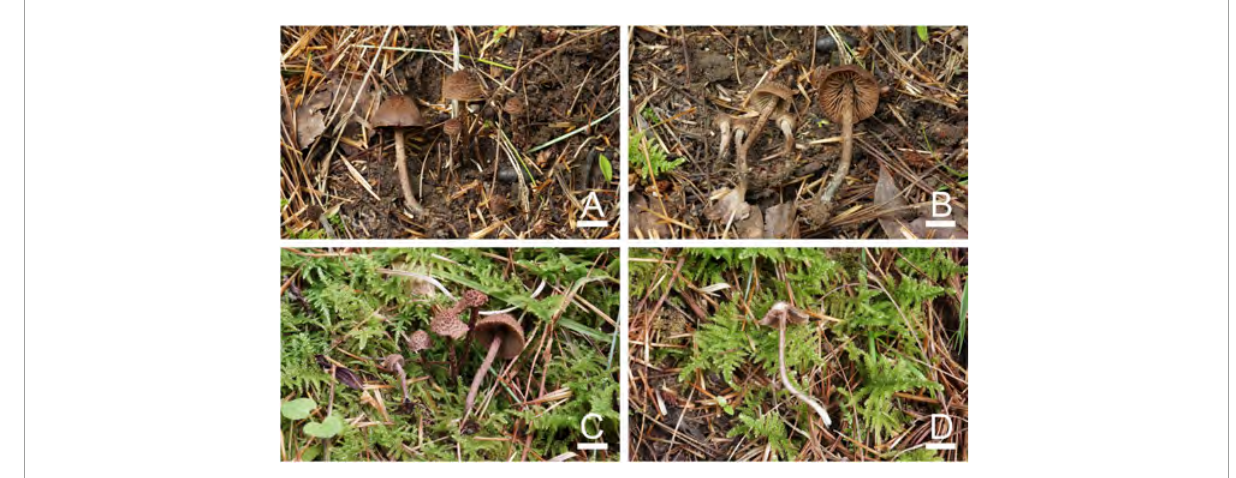
FIGURE8 Basidiomata of Inosperma squamulosobrunneum . (A,B) MHHNU32359, holotype and (C,D) MHHNU32351. Scale bars = 10 mm.